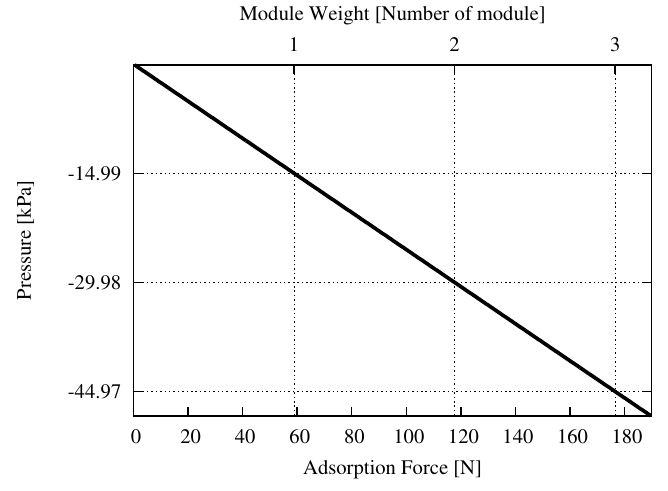
Figure 11. The relation between required vacuum pressure to the adsorption